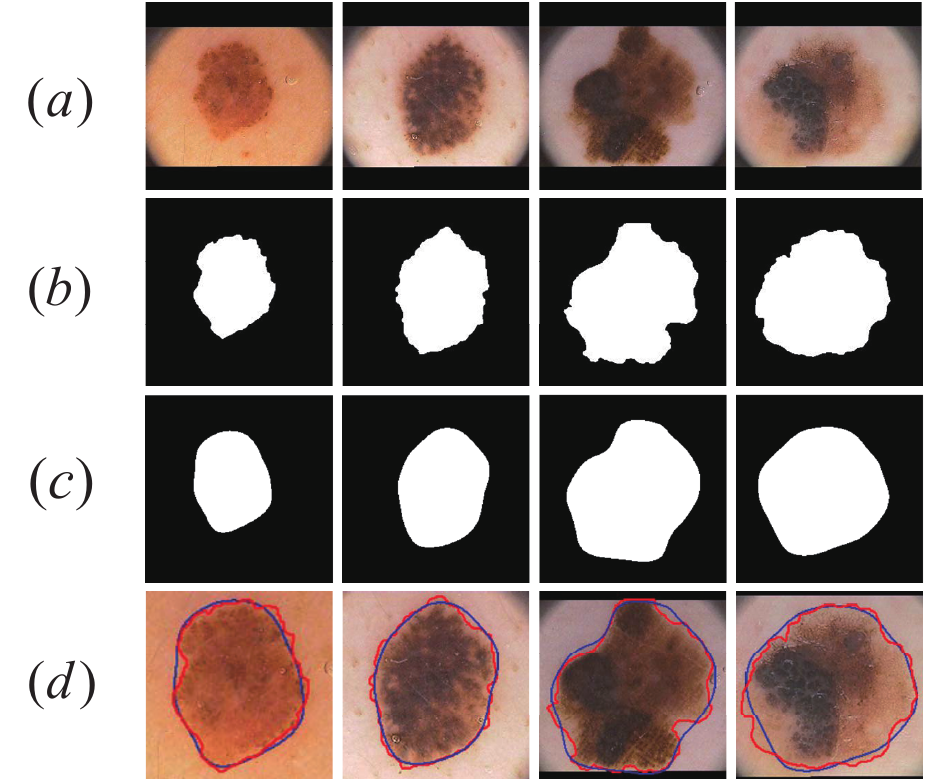
Figure 12. Visualization results for the PH2 data set. ( a ) Original skin lesion image; ( b ) ground truth corresponding to the lesion. ( c ) CSARM-CNN model lesion segmentation results; ( d ) ground truth (red) and segmentation results (blue) comparison